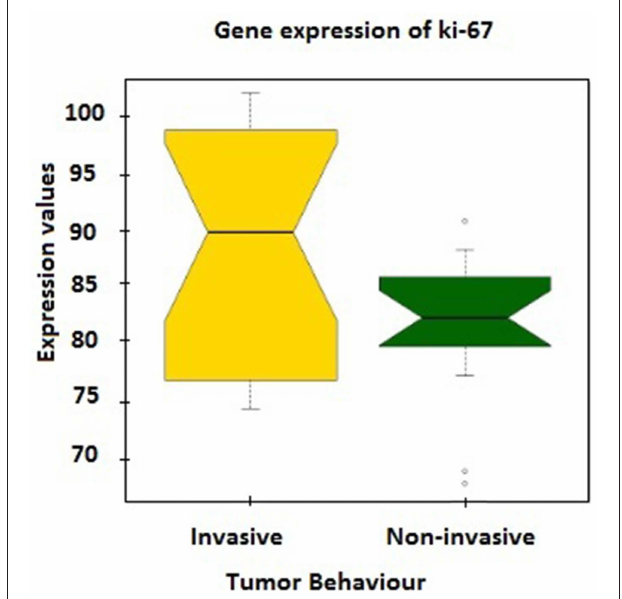
FIGURE 1 | The expression values of MKI67 gene, which encodes Ki-67 protein, between tumor